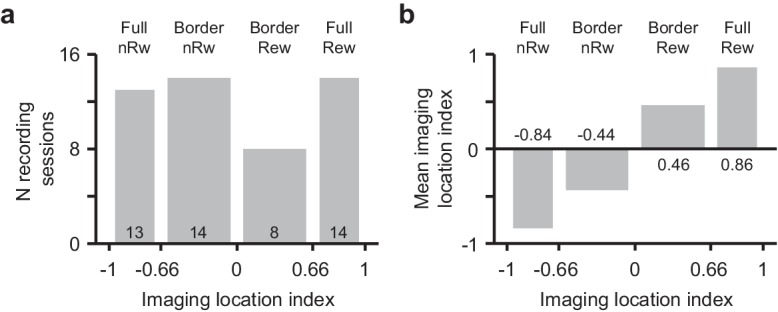
Binning of recording location into discrete groups.(a) Histogram of the number of recording sessions with an imaging location index (see Online Materials and methods for details) ranging from −1 (Non-rewarded side, nRw) to +1 (Rewarded side, Rew), classified as ‘Full non-rewarded’, ‘Border non-rewarded’, ‘Border rewarded', ‘Full rewarded’. The width of the bar is indicative of the range of included session location indices. (b) Mean imaging location index in each of the location bins showing a linear increase of location selectivity.